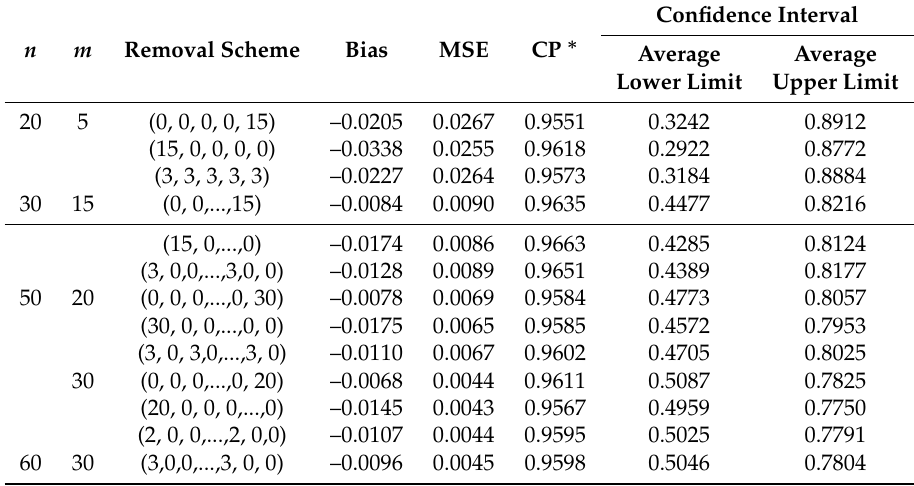
Estimation results of δ s , k using the parametric percentile bootstrap method